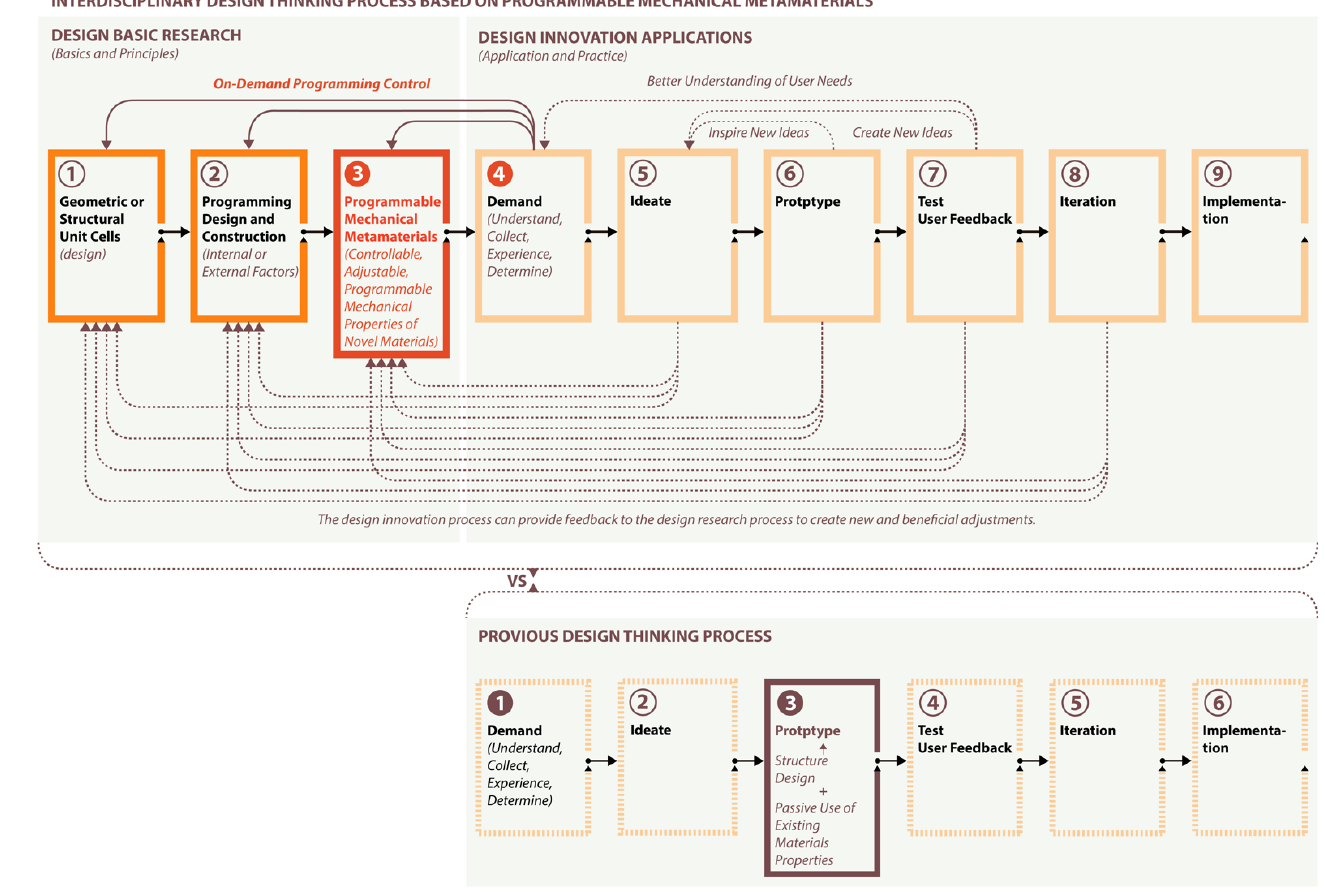
Figure 7. Interdisciplinary Design Thinking Process Model based on Programmable Mechanical Metamaterials.